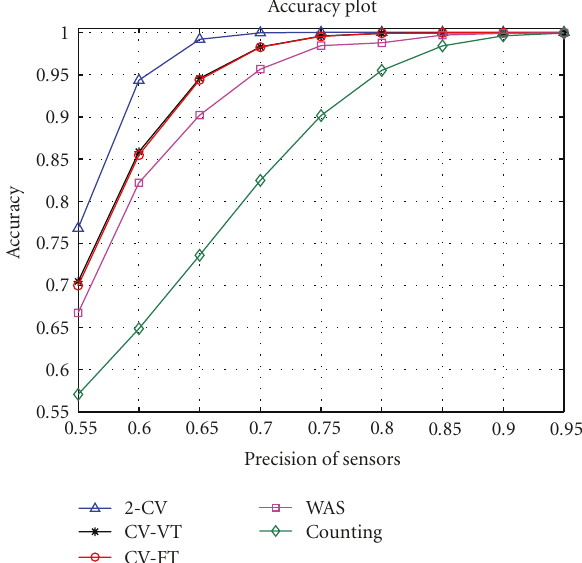
Figure 9: Numerical plots of detection accuracy with respect to precision of sensors p for various aggregation